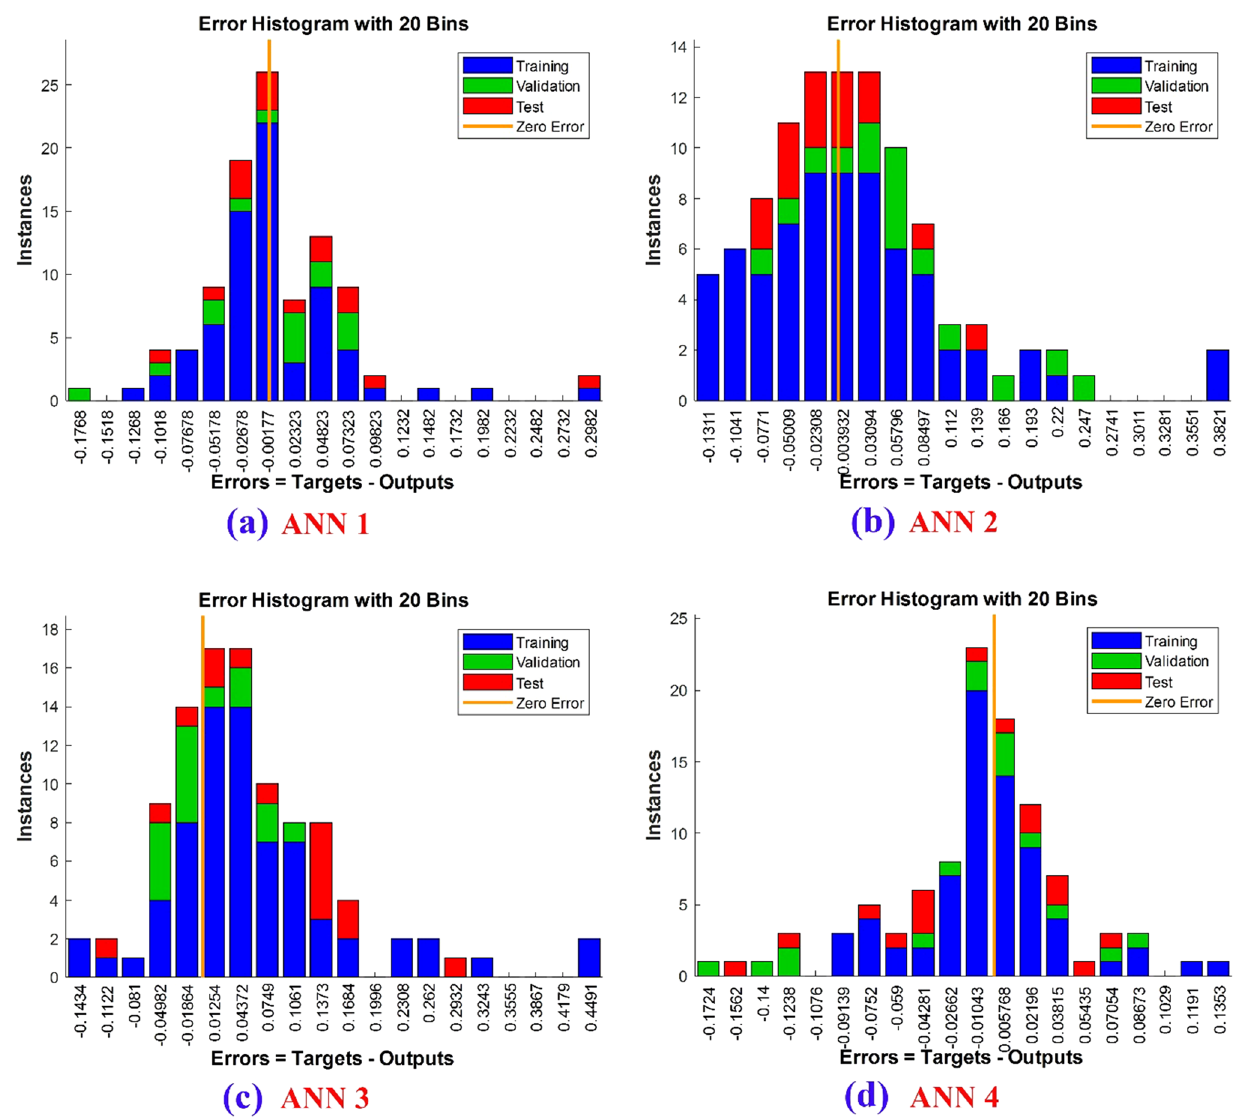
Fig. 21 The error histogram history of the ANN models for liquefaction prediction, a Model No.1 (ANN 1), b Model No.2 (ANN 2), c Model No.3 (ANN 3), d Model No.4 (ANN